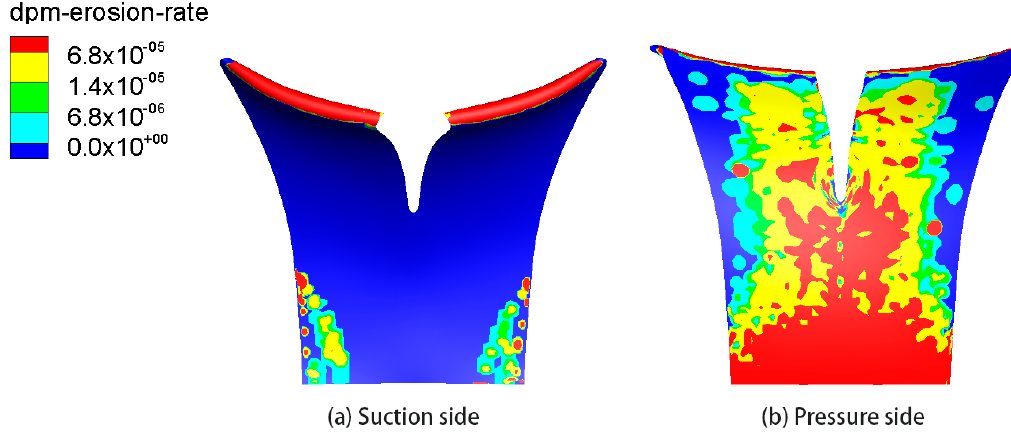
Figure 11. Silt erosion on blade surface (units: μ m/s, particle size: 0.4725 mm).